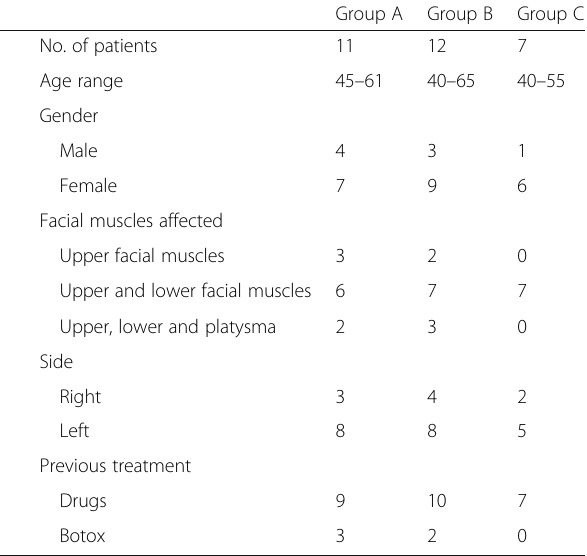
Table 1 Distribution of age, gender, facial muscles affected, side, and previous treatments